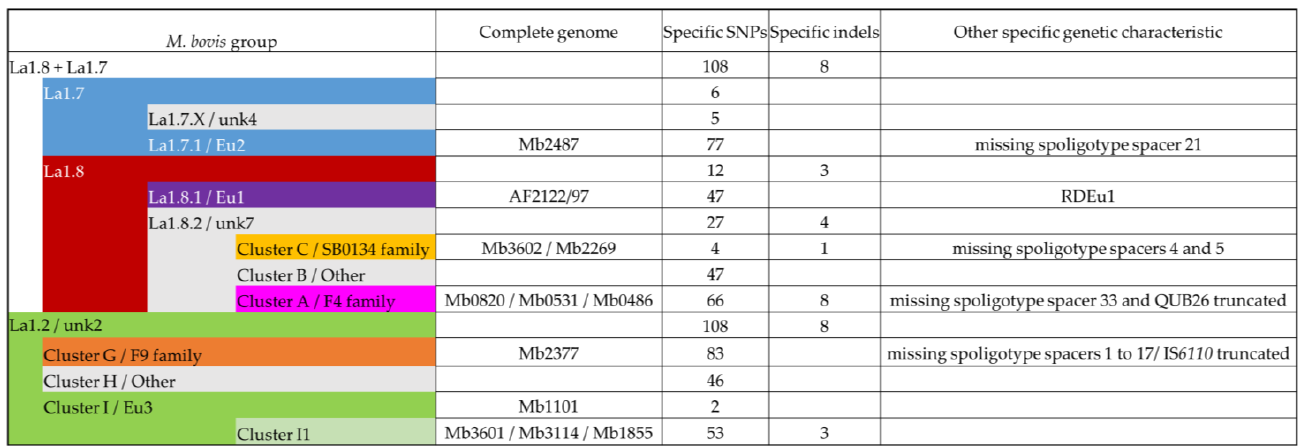
Figure 4. M. bovis isolates separated into clusters. The heatmap illustrates pairwise SNP distance between genomes belonging to each cluster. Both axes have a maximum-likelihood SNP-based tree inferred on 98 genomes with leaf colored according to cluster defined in this study. Trees were mid- point rooted. The SNP difference key is shown on the right.